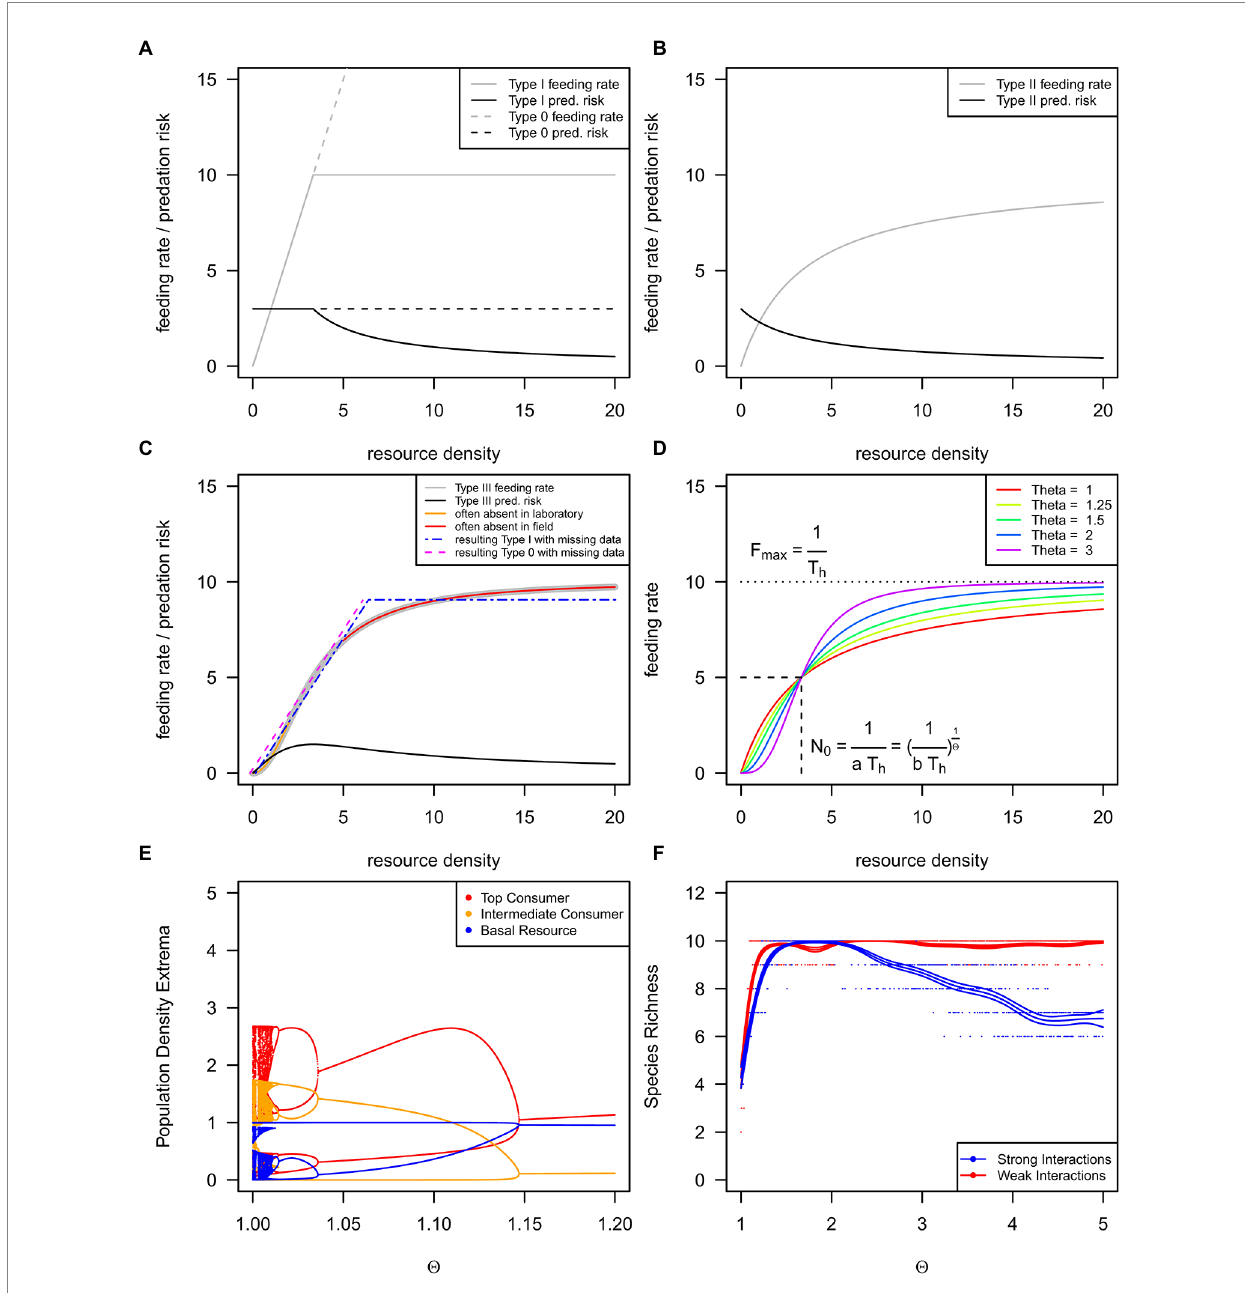
FIGURE 1 We show the three basic functional response types as grey lines and the corresponding per-resource item consumption risks as black lines (A–C) . The type I functional response appears in the literature as a rectilinear [ (A) , solid grey line, H1] or strictly linear function [ (A) , dashed grey line, H0], but see Table 1 for details. An inadequate resource density range may lead to incorrect response type classification (C) . The rectilinear functional response (H1) may be found if low resource densities are lacking in experiments (Sarnelle and Wilson, 2008), as shown by the orange line and blue dotted-dashed line in (C) . The strictly linear functional response (H0) may be found if high, saturating resource densities rarely occur in natural conditions (Coblentz et al., 2022a); see magenta dashed and red lines in (C) . The generalized or θ -sigmoid functional response (D) can exhibit differently strong